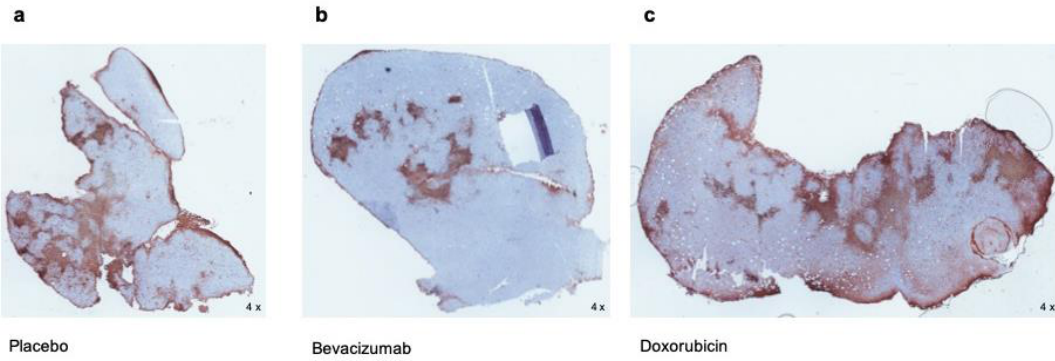
Figure 3. Immunohistochemistry for S100A9. Microscopic overview images (4-fold magnification) of paraffin-embedded whole tumor slices. Staining with an anti-S100A9-antibody (positive cells in brown). Visually inspected, the number of S100A9-positive cells correlates with the respective fluorescence intensities of the different treatment groups under ( a ) placebo, ( b ) Bevacizumab, and ( c ) Doxorubicin.